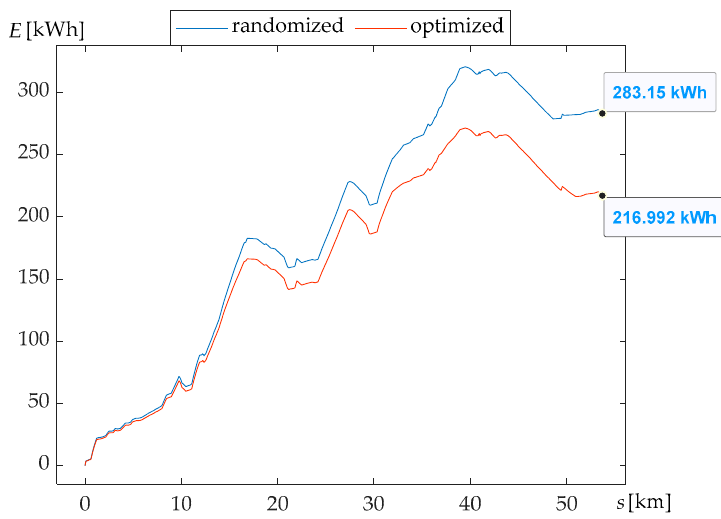
Figure 9. Demand of the energy (red is optimized, blue is randomized).